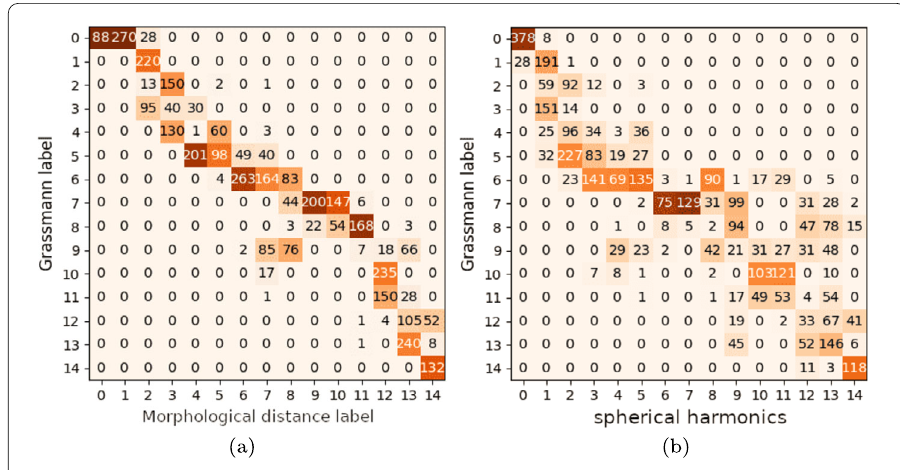
Figure 16 Confusion matrices showing the number of shapes in the clustering based on the Grassmann distance and that based on either the morphological ( a ) and spherical harmonics ( b ) distance, after data